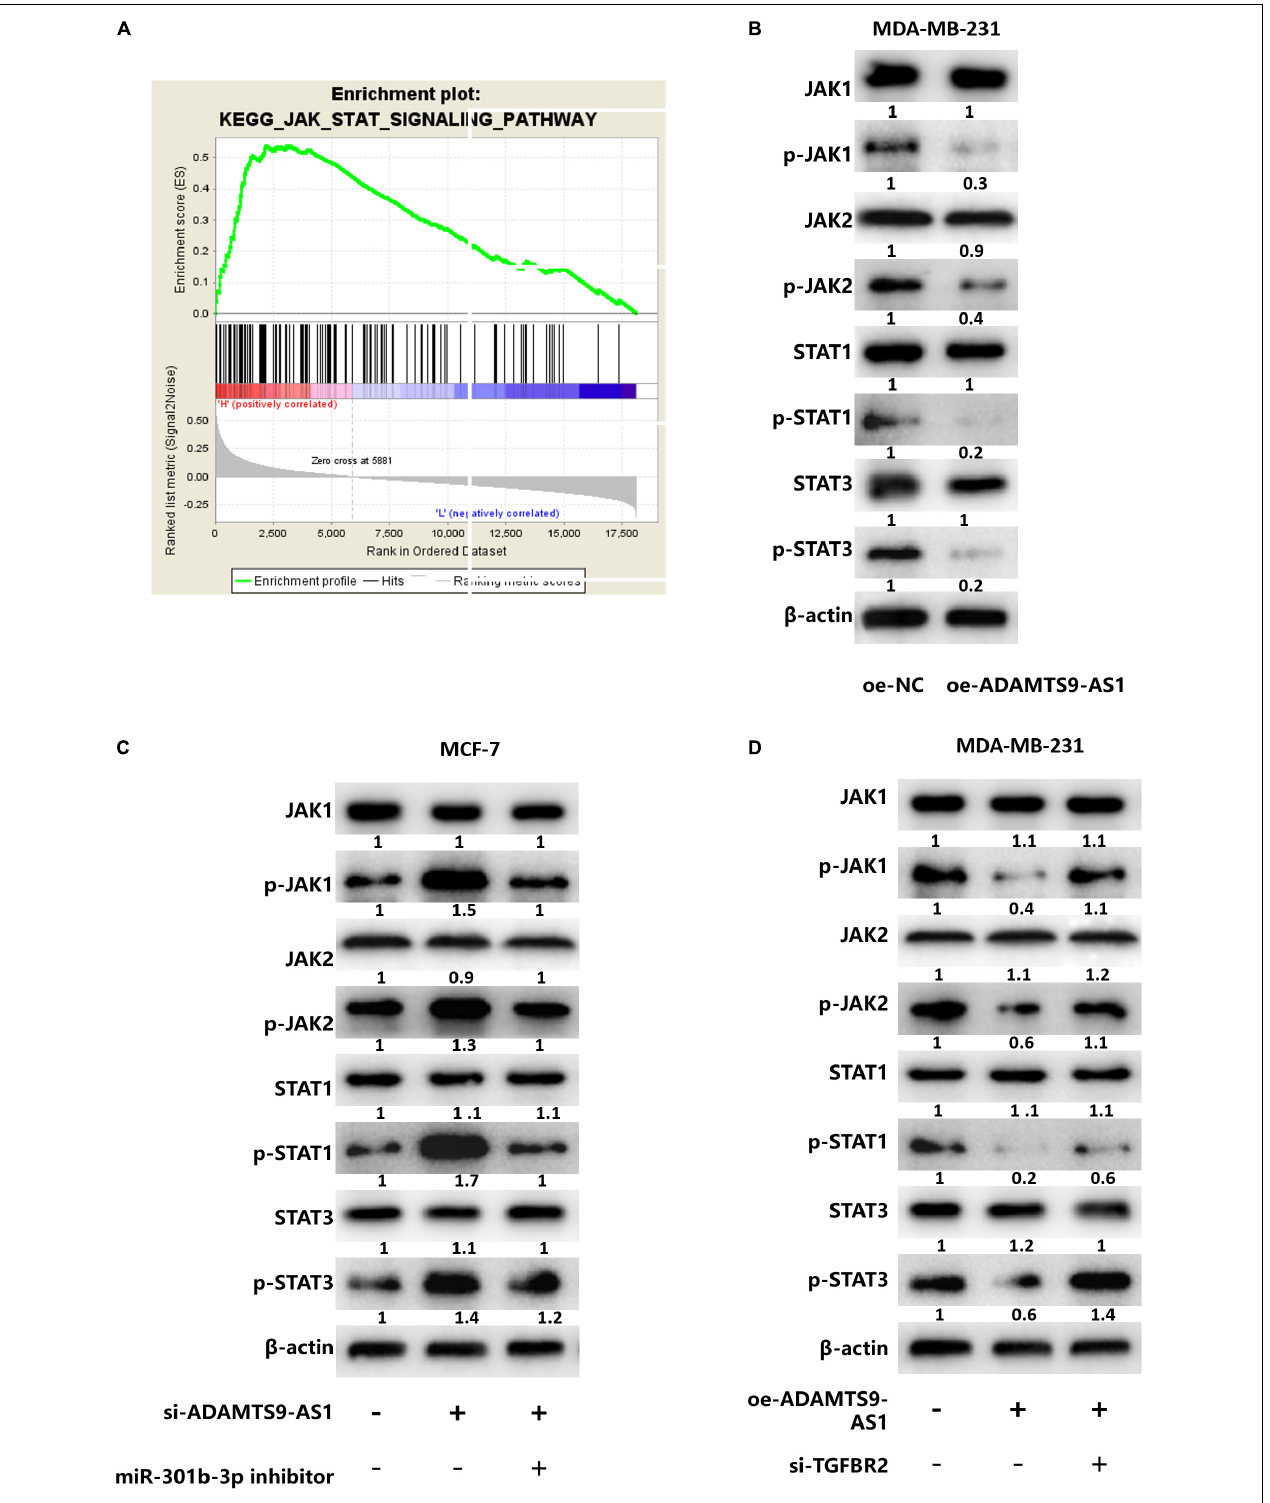
FIGURE 5 | ADAMTS9-AS1 regulates the JAK STAT signaling pathway by targeting TGFBR2 through miR-301b-3p. (A) GSEA enrichment pathway of TGFBR2 (JAK STAT signaling pathway). (B) The expression of JAK STAT signaling-relevant proteins. (C) The expression of JAK STAT signaling-relevant proteins in si-NC + inhibitor NC, si-ADAMTS9-AS1 + inhibitor NC and si-ADAMTS9-AS1 + miR-301b-3p inhibitor. (D) Levels of JAK STAT signaling-relevant proteins in oe-NC + si-NC, oe-ADAMTS9-AS1 + si-NC and oe-ADAMTS9-AS1 + si-TGFBR2.